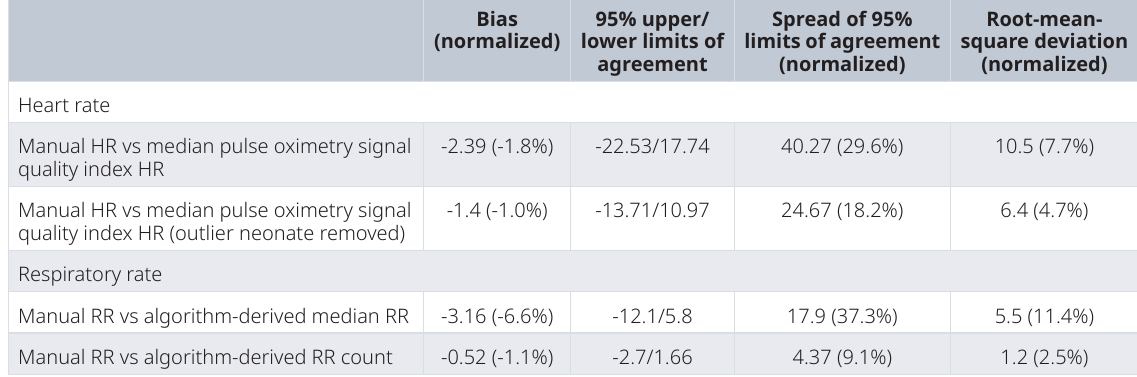
Table 4. Bland-Altman analysis of heart rate (HR) and respiratory rate (RR) methods.